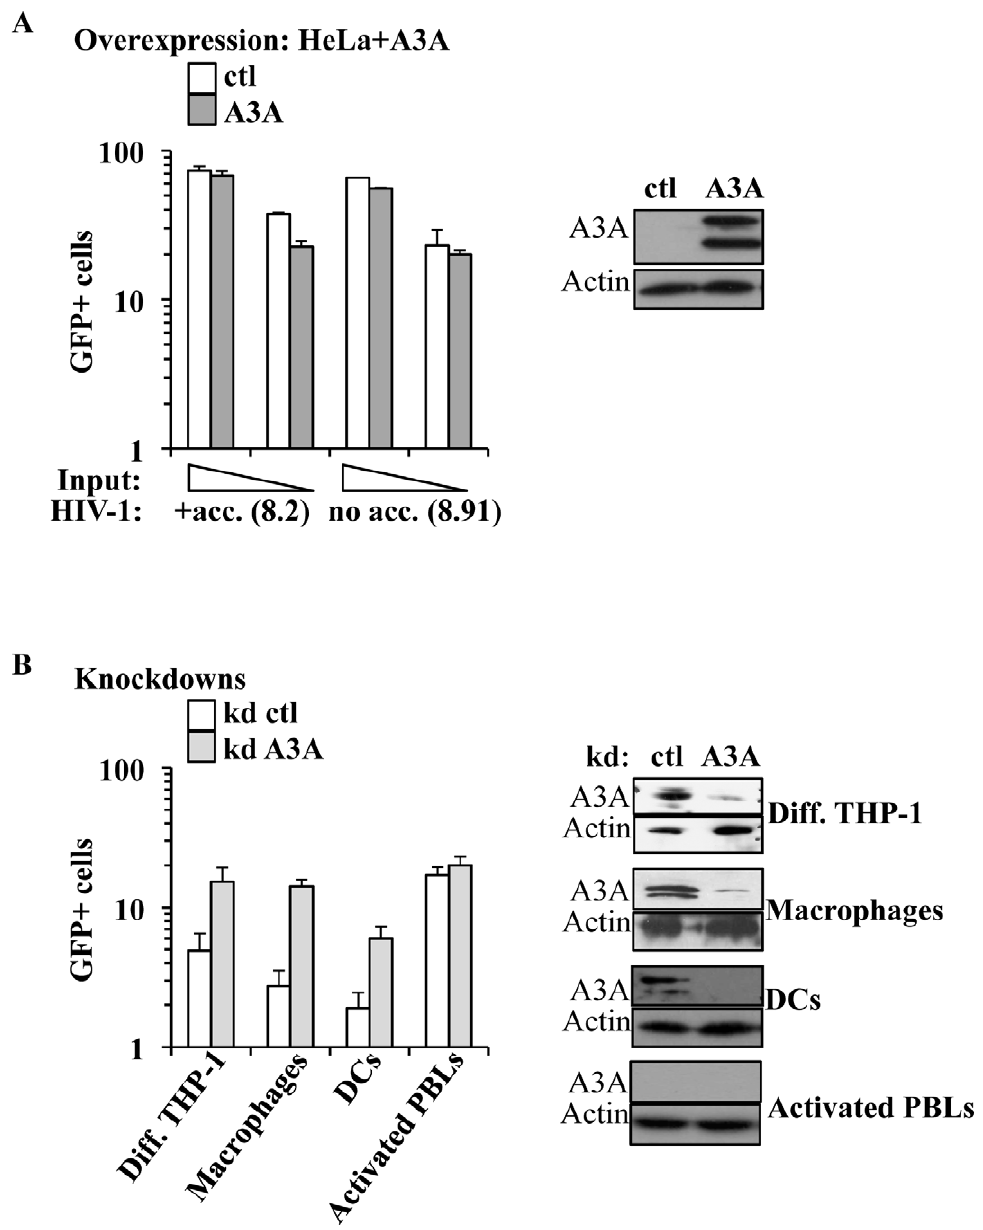
Figure 3. A3A inhibits the early phases of HIV-1 infection specifically in myeloid cells. A) HeLa cells were transfected with either control or HA-tagged A3A coding constructs and analyzed by WB or challenged 48 hours after transfection with different inputs of VSVg-pseudotyped complete or minimal HIV-1 vectors (i.e. coding or not viral non-structural proteins), carrying a GFP expression cassette in a single-round infectivity assay. The percentage of infected cells was determined 3 days later by flow cytometry. The graph presents averages from 4 different experiments. B) Control or A3A knockdowns were obtained upon LV-mediated transduction of PMA-differentiated THP-1 cells, macrophages, DCs and PHA/IL2- activated PBLs with an equal viral input of miR-shRNAs coding vectors. Four days later, stably silenced cells were analyzed by WB (right panel, presenting representative experiments) or challenged with VSVg-pseudotyped GFP-coding HIV-1 vectors (at MOIs comprised between 3 and 5). The graph presents data obtained from 3 to 6 independent